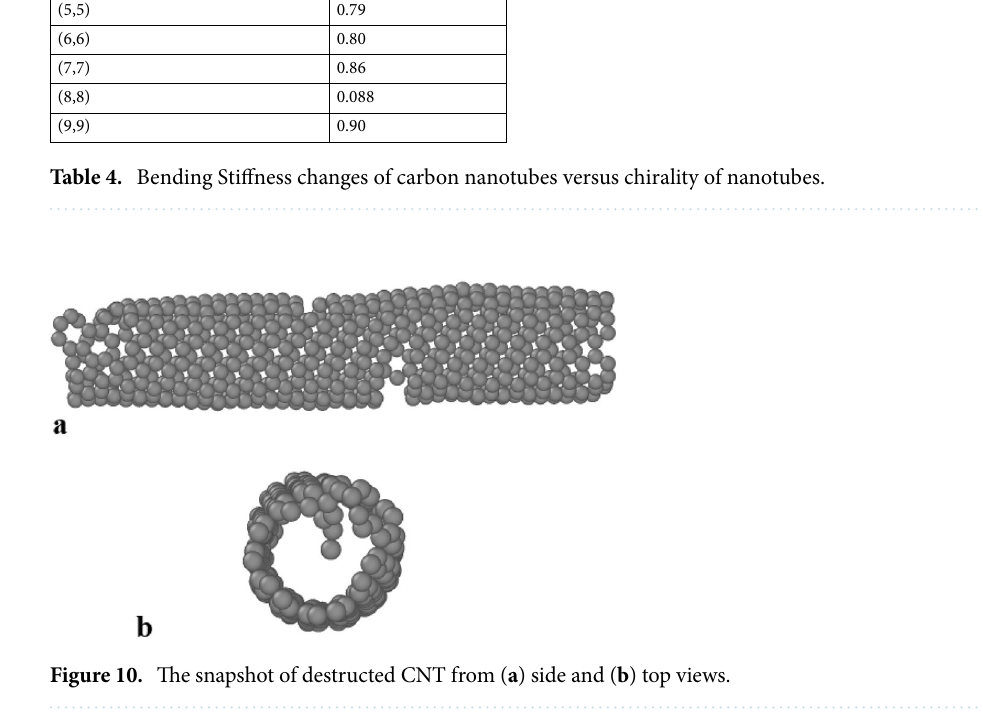
Chirality of carbon nanotubes (Å)